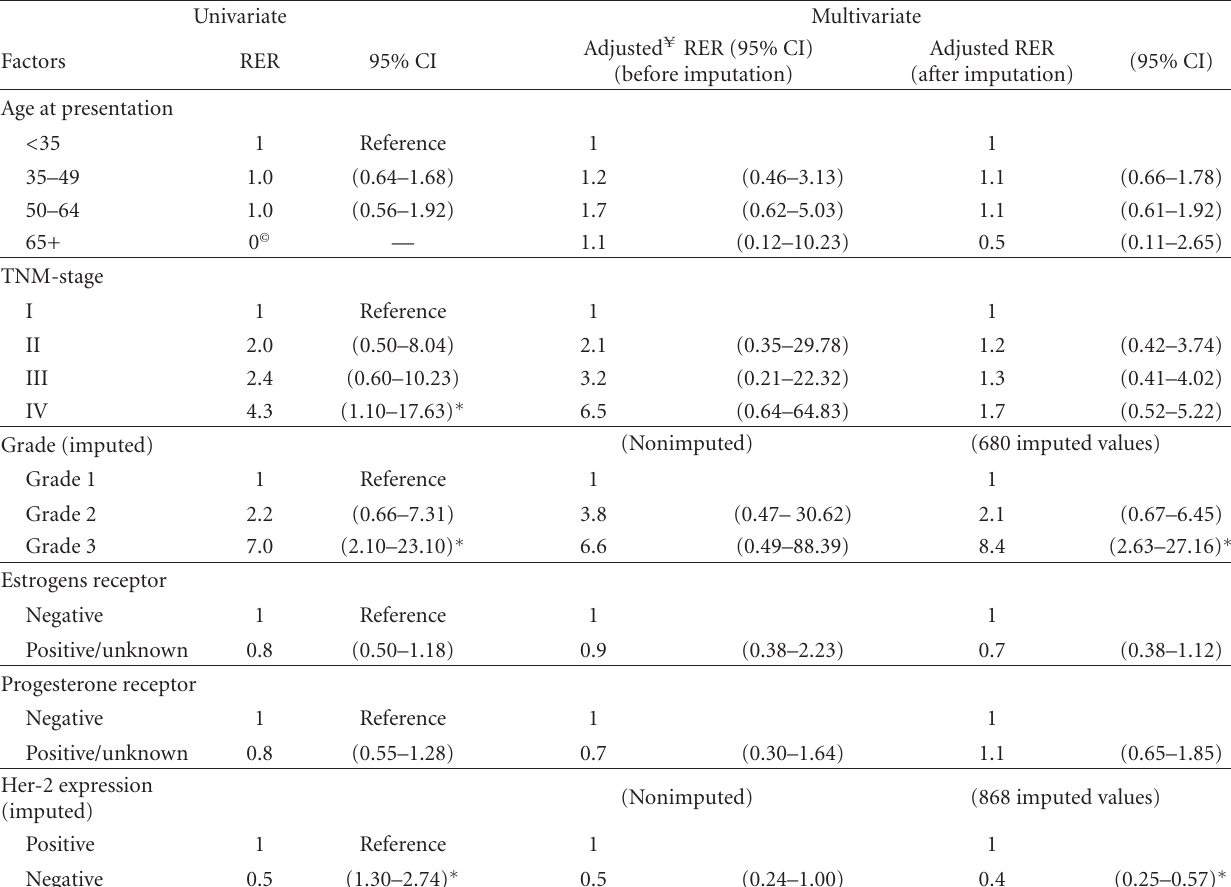
Table 4: Relative excess risk of breast cancer death in Iranian women diagnosed in 1999–2001. Univariate